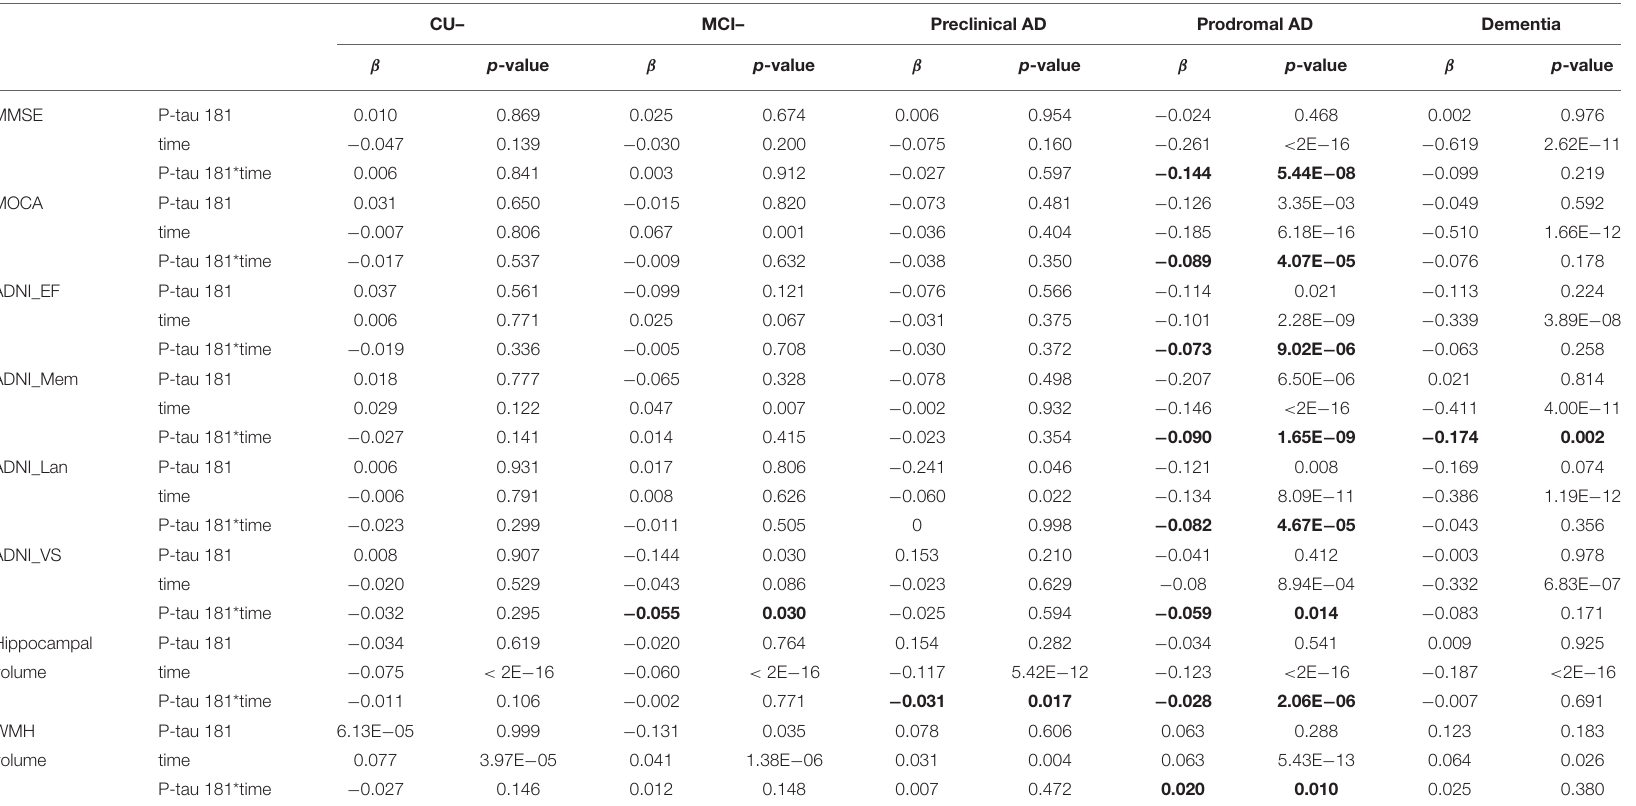
TABLE 2 | Baseline plasma p-tau 181 and change in volume of hippocampus and WMH and